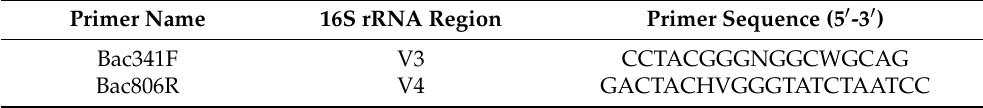
Table 1. Primer used for amplification of 16S rRNA